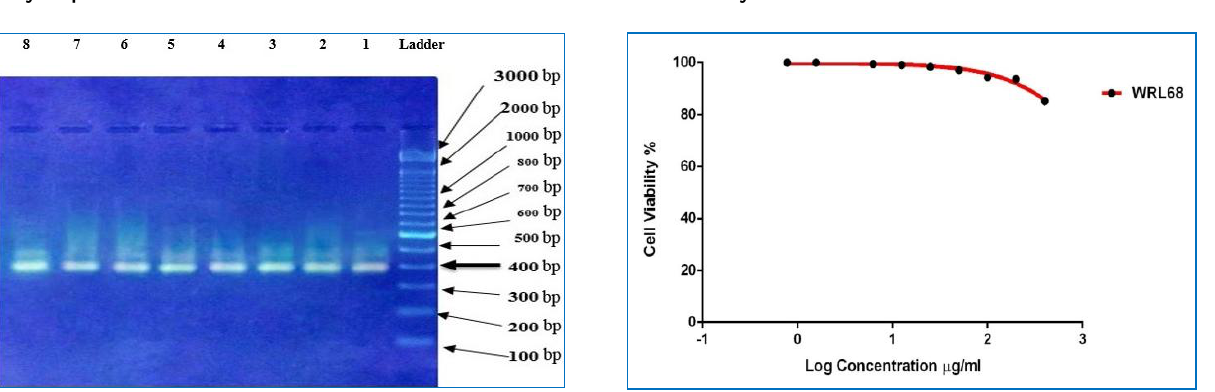
Figure, 4: The activity of purified enzyme on WRL-68 cell line